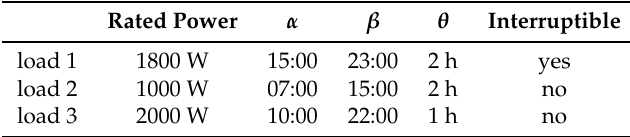
Table 2. Schedulable loads of User 1.